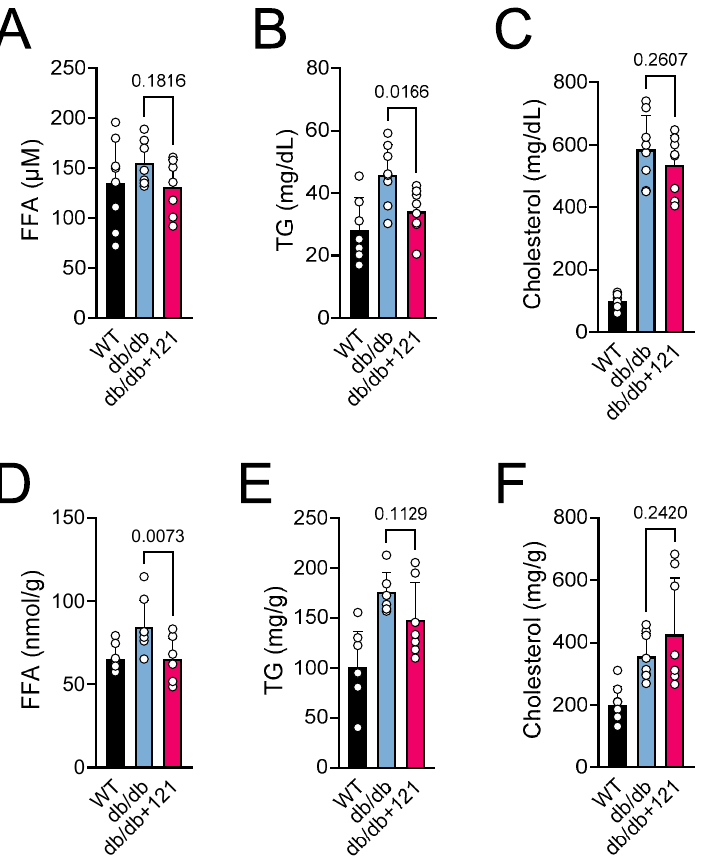
Figure 3. Blood and liver lipids of db/db mice fed control diet or a diet containing CMS121. ( A , D ) Free fatty acids (FFA), ( B , E ) triglycerides (TG), and ( C , F ) cholesterol were evaluated in plasma ( A – C ) and liver ( D – F ) at the end of the treatment. Data are presented as mean ± SD (n = 7–8). p -values are indicated for the untreated db/db mice compared to the CMS121-treated mice. Values of WT mice are presented as a reference. One-way ANOVA was used to detect mean changes, and differences between db/db and db/db + 121 were evaluated by the Holm–Sidak post-hoc